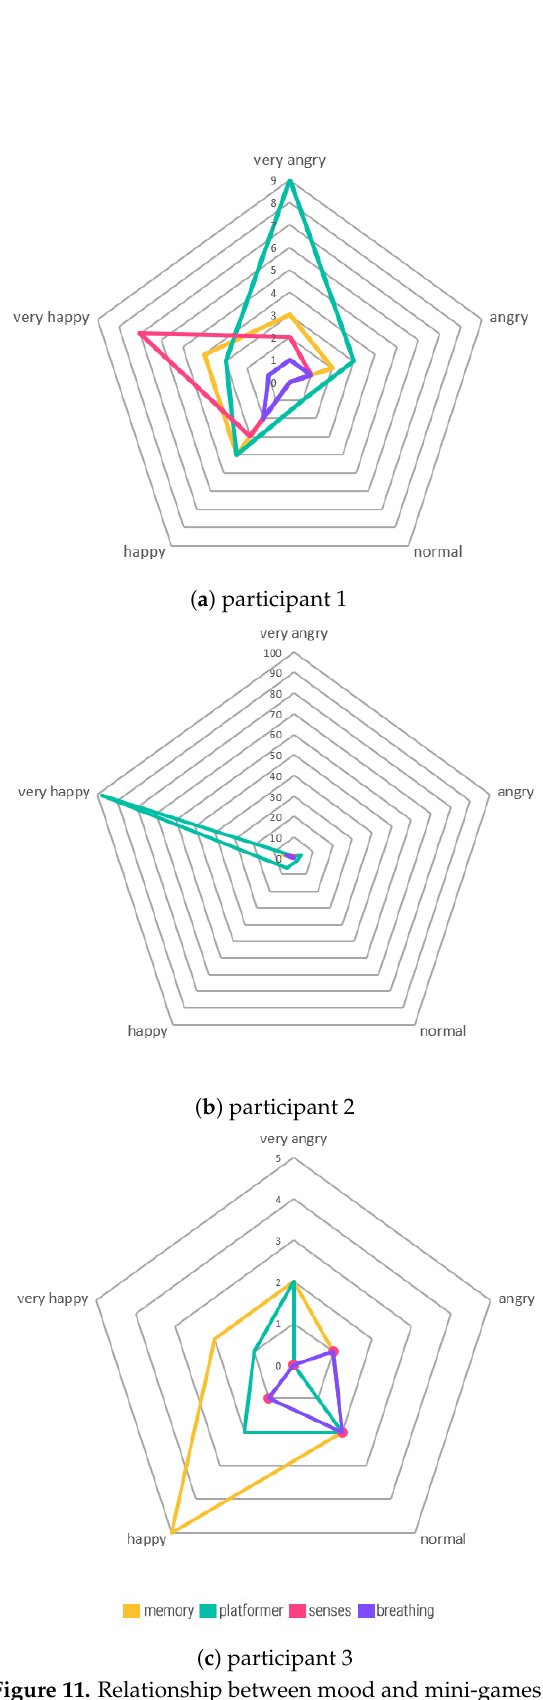
Figure 11. Relationship between mood and mini-games. The color chart in Figure 12 show the indicated mood for each mini-game during a gaming session. The vertical axis indicates the sessions, the horizontal axis shows the total number of mini-games in each session and the color of a cell indicates the